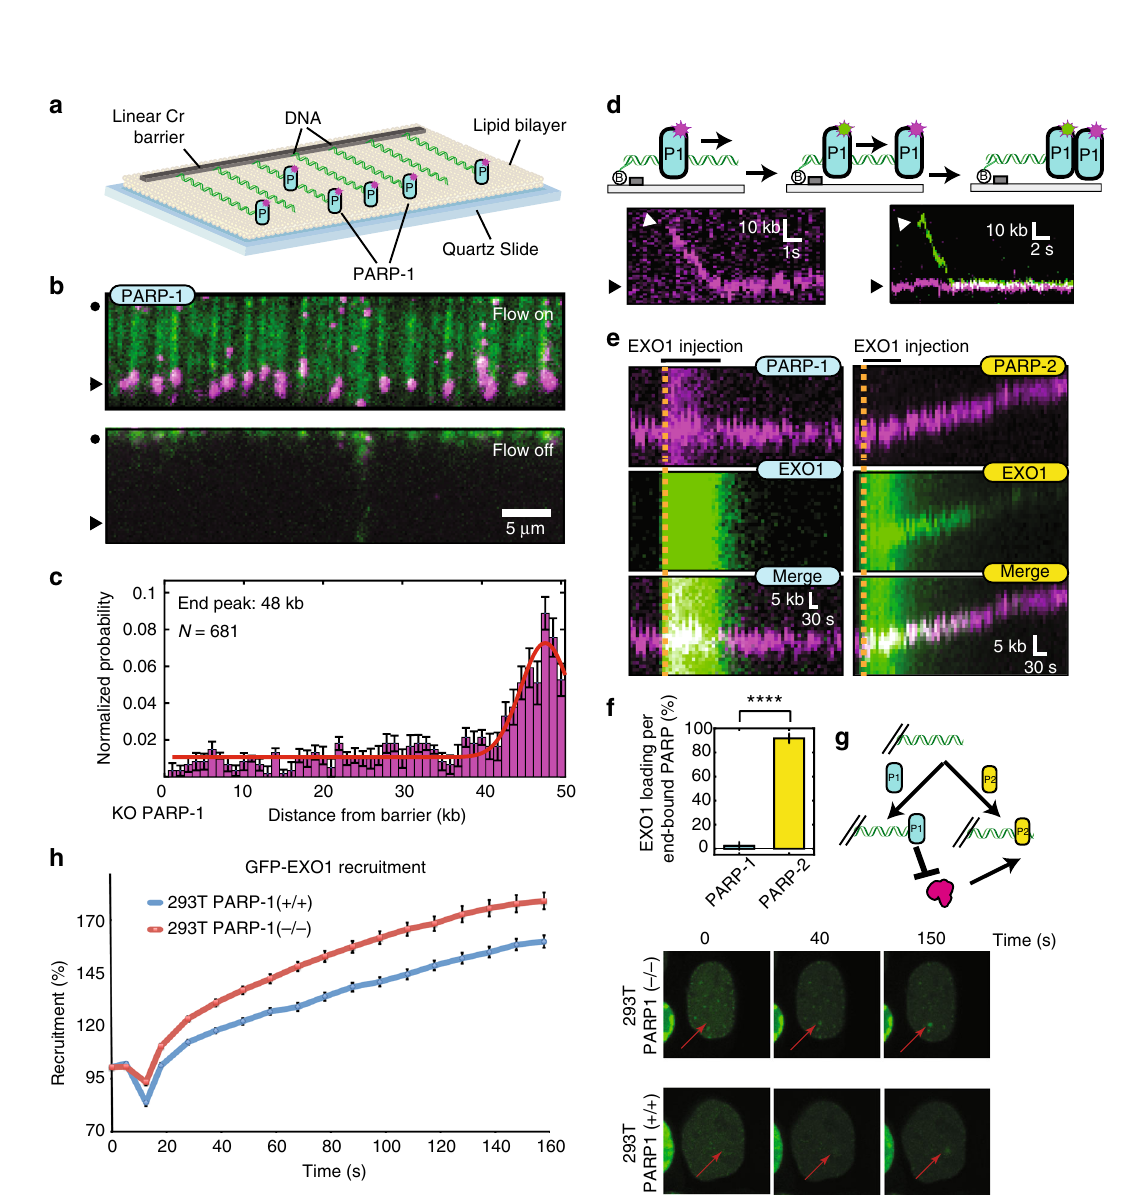
Fig. 5 Poly(ADP-ribose) polymerase-1 (PARP-1) slides to accumulate at ends and prevent EXO1 binding. a Illustration of the DNA curtain assay with fl uorescent PARP-1 (blue ovals). b Fluorescent PARP-1 (magenta) binding to DNA curtains in the presence (top) or absence (bottom) of buffer fl ow. Black circles indicate the diffusion barrier and arrows indicate the DNA ends. After PARP-1 was loaded, the DNA was stained with the fl uorescent intercalating dye YoYo-1. c Histogram of the positions of 681 individual PARP-1 molecules along the length of the DNA substrate. Error bars were calculated by bootstrapping the data 74 and indicate a 70% con fi dence interval. d Illustration (top) and kymograph (bottom) of two differently labeled PARP-1 (P1) molecules binding to the DNA end. PARP-1 reached the end by buffer fl ow-assisted one-dimensional sliding 88% of the time ( N = 109/124). e Representative kymographs of EXO1 resection of DNA pre-bound with PARP-1 (left) or PARP-2 (right). f Quanti fi cation of EXO1 loading events per DNA end bound by PARP-1 (left; 2.4 ± 3.4%; N = 42 PARP-1 molecules) or PARP-2 (right; 91.8 ± 4.1%; N = 65 PARP-2 molecules). Error bars represent mean ± s. e.m. **** p ≤ 0.0001, (Student ’ s t test). g Model for PARP-1 inhibition of EXO1. P2 refers to PARP-2. YoYo-1 was omitted from all experiments described